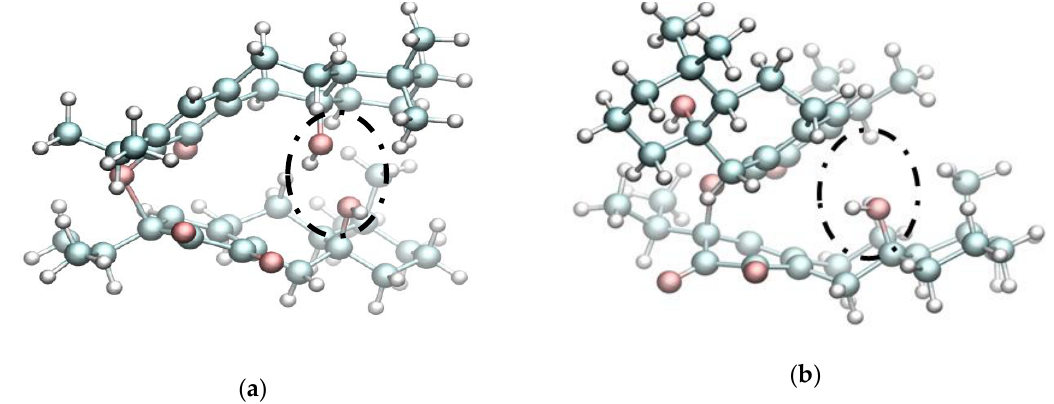
Figure 5. Equilibrium geometries of the endo transition state of grandione β ( a ) and isograndione β ( b ) showing an emergent steric repulsion due to the hydroxyl moiety orientation.